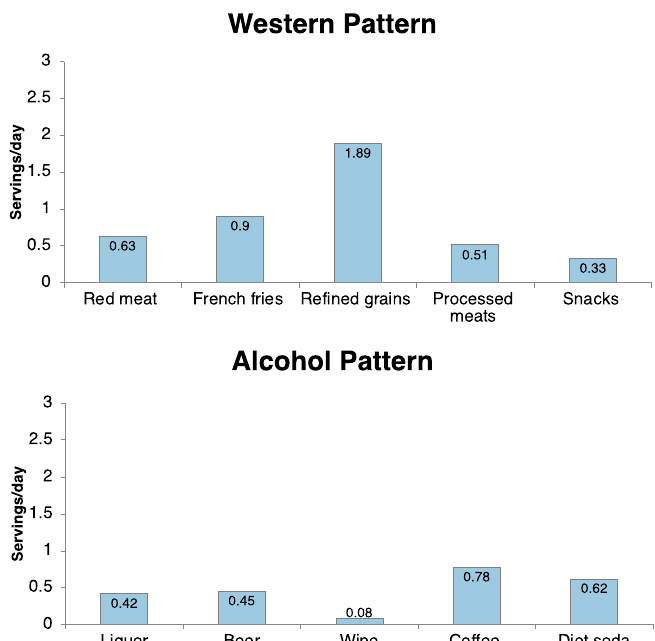
Figure 2. Mean daily medium serving intakes of participants with scores in the top quartile of the three dietary patterns for the foods/food groups with the highest factor loadings. Medium serving sizes of food items are as follows: Red meat (4.2 ounces), French fries (0.75 cups), Refined grains (1 piece), Processed meats (2 pieces), Snacks (1 cup), Fruit (0.5 cups), Dark yellow-orange vegetables (0.5